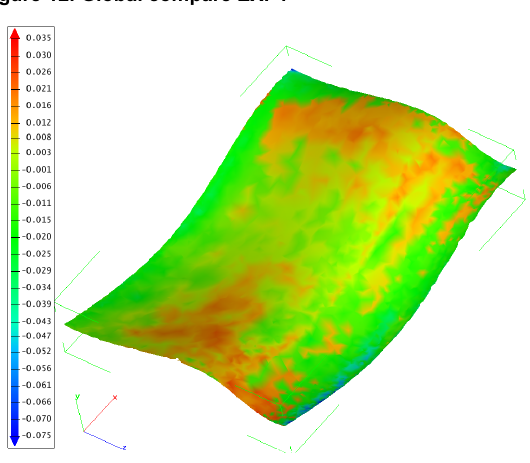
Figure 13. Global compare EXP4 Numerical form deviations of randomly selected points at the machining surface are shown in Figures 14 and 16. Estimating cross-sectional deviation includes determining a deviation vector whose intensity corresponds to deviation levels 15 and 17. This way of displaying deviation is visually less clear but gives a better insight into deviation values in specific areas.